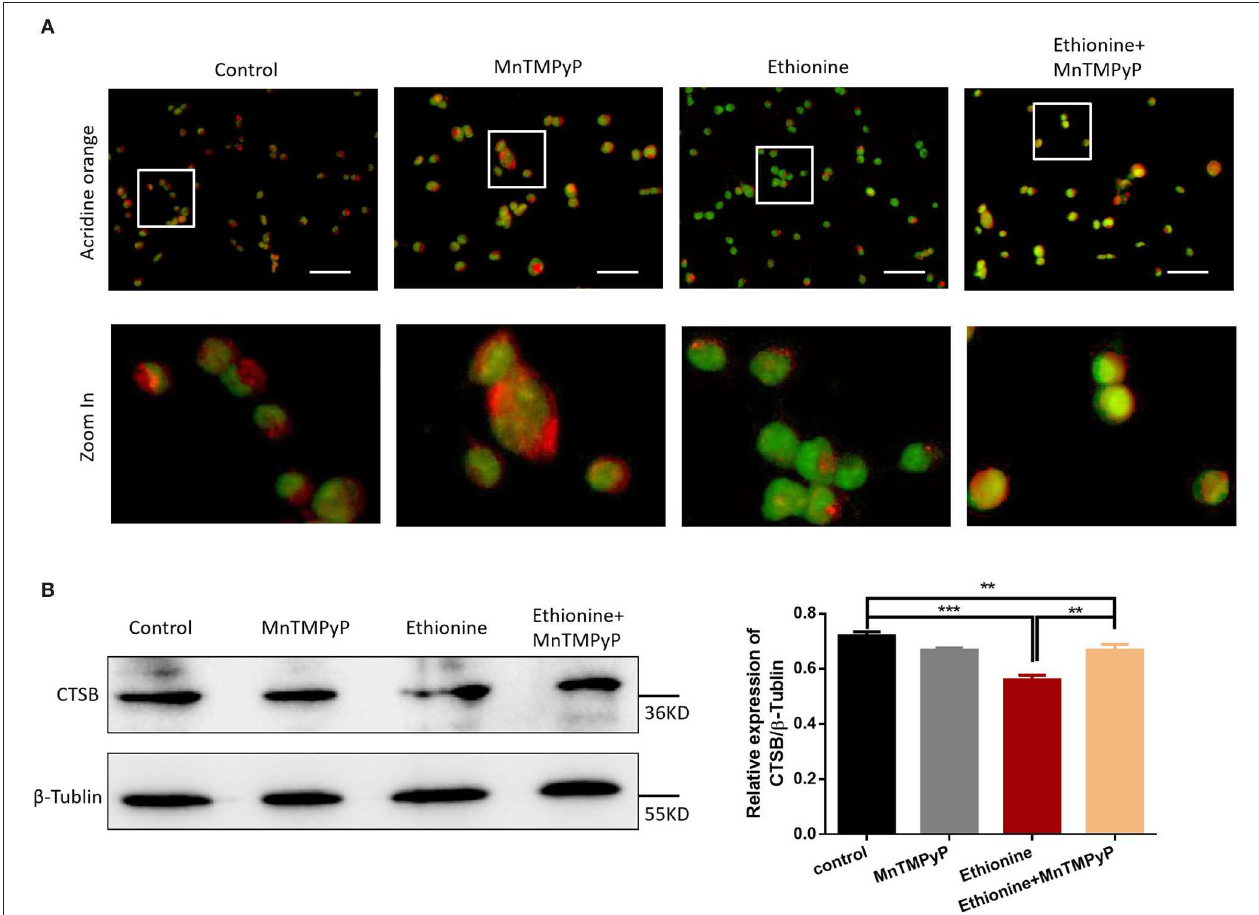
FIGURE 5 | Ethionine induced lysosomal alkalization. (A) HT-22 cells were treated with ethionine and MnTMPyP, and lysosomal alkalization levels were determined using AO dye. Representative images are shown. Scale bars: 100 µ m. (B) CTSB protein level in control and experiment groups was evaluated via Western blotting. β -Tublin levels were also evaluated to confirm equal loading ( n = 3), Each experiment was carried out in triplicates ** P < 0.01 and *** P <